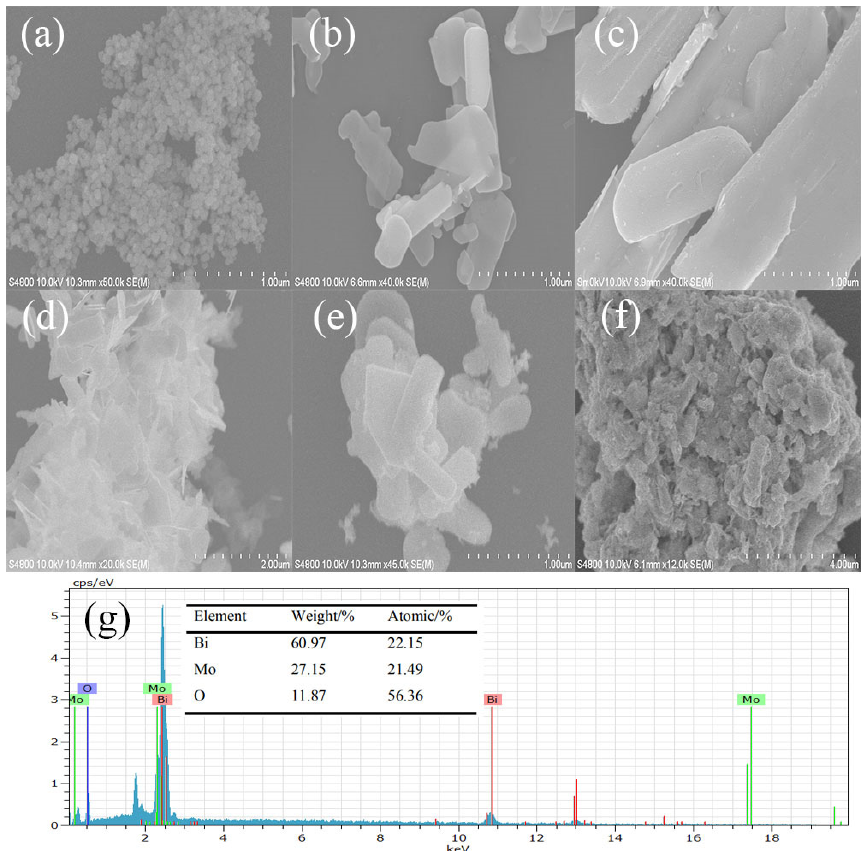
Figure 3. SEM images of the as-prepared samples: ( a – d ) γ -Bi 2 MoO 6 (pH = 8, 9, 10, and 11, nitric acid method, 180 °C), ( e ) 4 wt % Pt/ γ -Bi 2 MoO 6 (nitric acid method, pH = 9, 180 °C), ( f ) recycled 4 wt % Pt/ γ -Bi 2 MoO 6 (nitric acid method, pH = 9, 180 °C), and ( g ) the corresponding EDX spectra of γ -Bi 2 MoO 6 (nitric acid method, pH = 9, 180 °C).